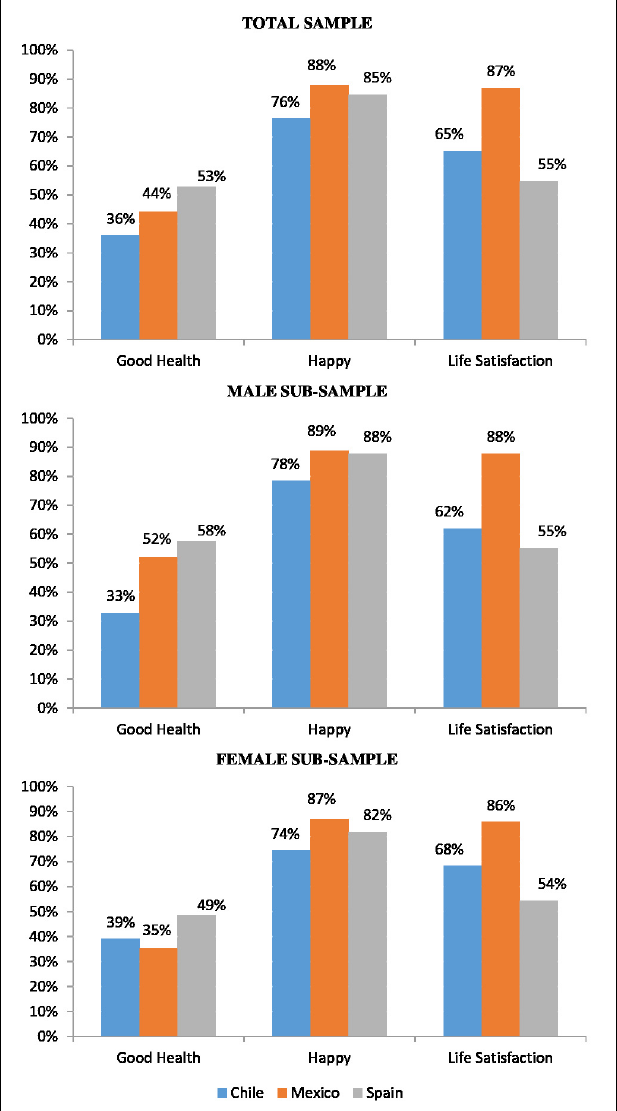
FIGURE 1 | Health and wellbeing indicators (Wave: